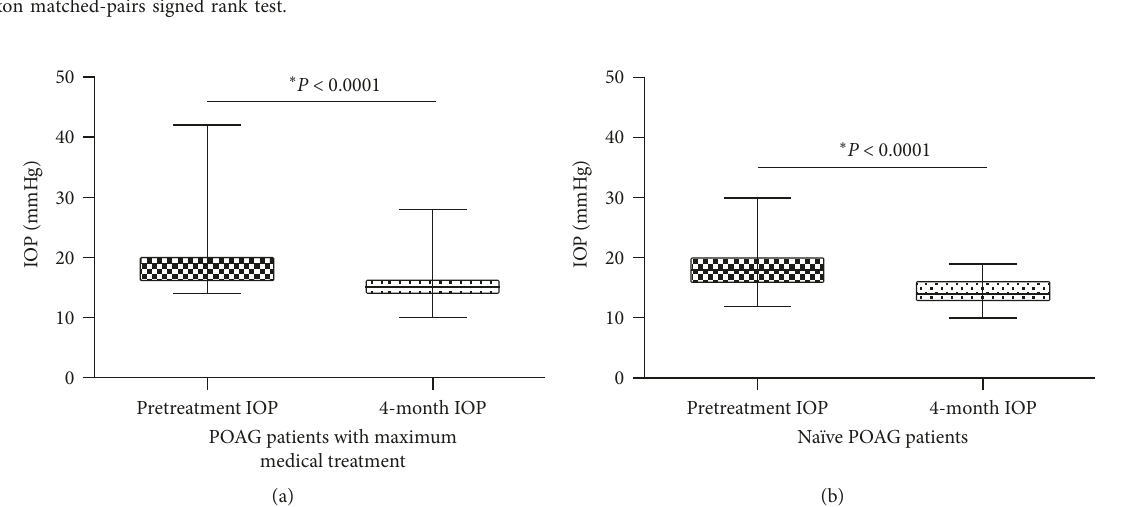
Figure 3: (a) Comparison between IOP values obtained before electrical stimulation to those measured at the four-month follow-up visit for POAG patients receiving the maximum tolerated medical treatment. (b) Comparison between IOP values obtained before electrical stimulation to those measured at the four-month follow-up visit from na¨ıve patients.